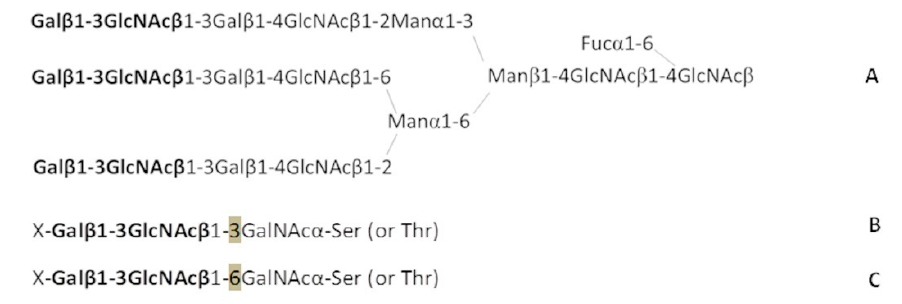
Figure 4. Structures of the discussed N-and O-glycoprotein chains: A , triantennary N-chain; B , the Le C disaccharide is attached to the 3-position of the inner N-acetylgalactosamine of the O-chain; C , the Le C disaccharide is attached to the 6-position of the inner N-acetylgalactosamine of the O-chain. X is a substituent at position 3 or 6 of the Gal β moiety.